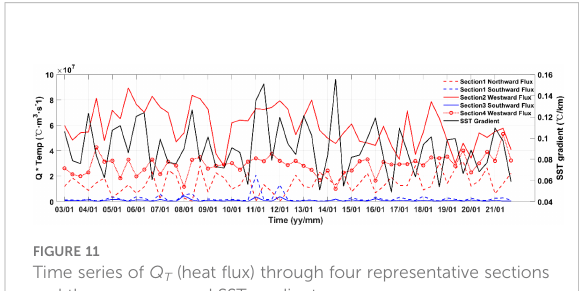
FIGURE 11 Time series of Q T (heat fl ux) through four representative sections and the area-averaged SST gradient.